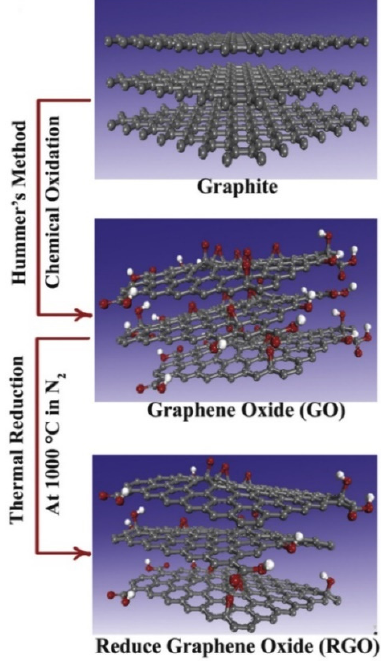
Figure 6. Schematic formation from graphite, GO to rGO. Reprinted with permission from [78]. Copyright Elsevier, 2019